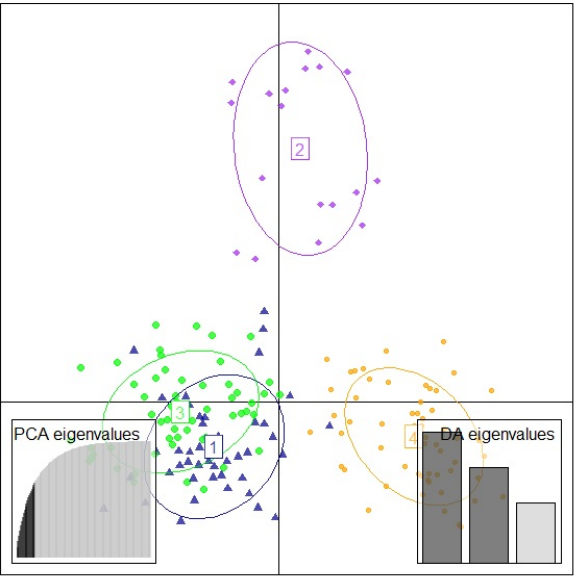
Figure 5. The scatterplot of discriminant analysis of principal components result using 12 microsatellite data. 1, Simmental Purebred; 2, Simmental Cross West Sumatra; 3, Simmental Cross West Java; 4, Ongole Grade (PO) breed. PCA, principal component analysis; DA, discriminant analysis.